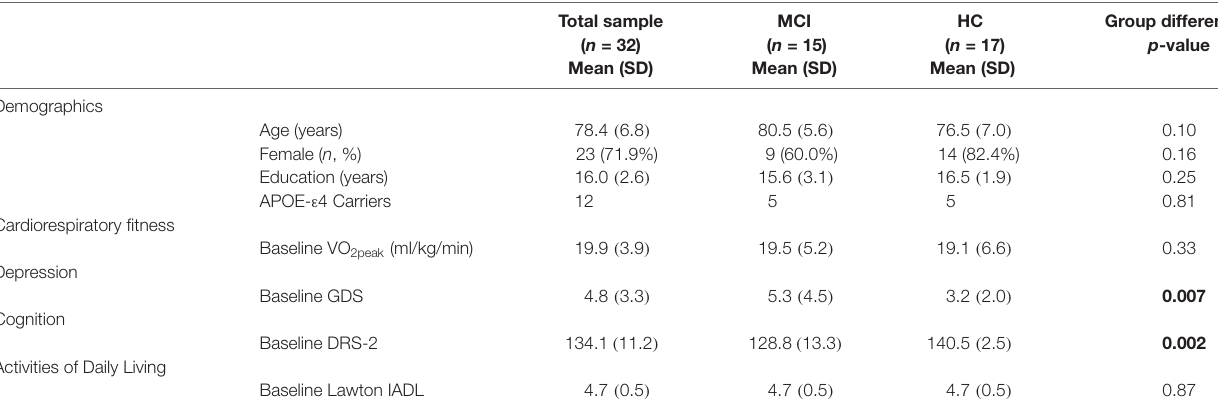
TABLE 1 | Baseline demographic